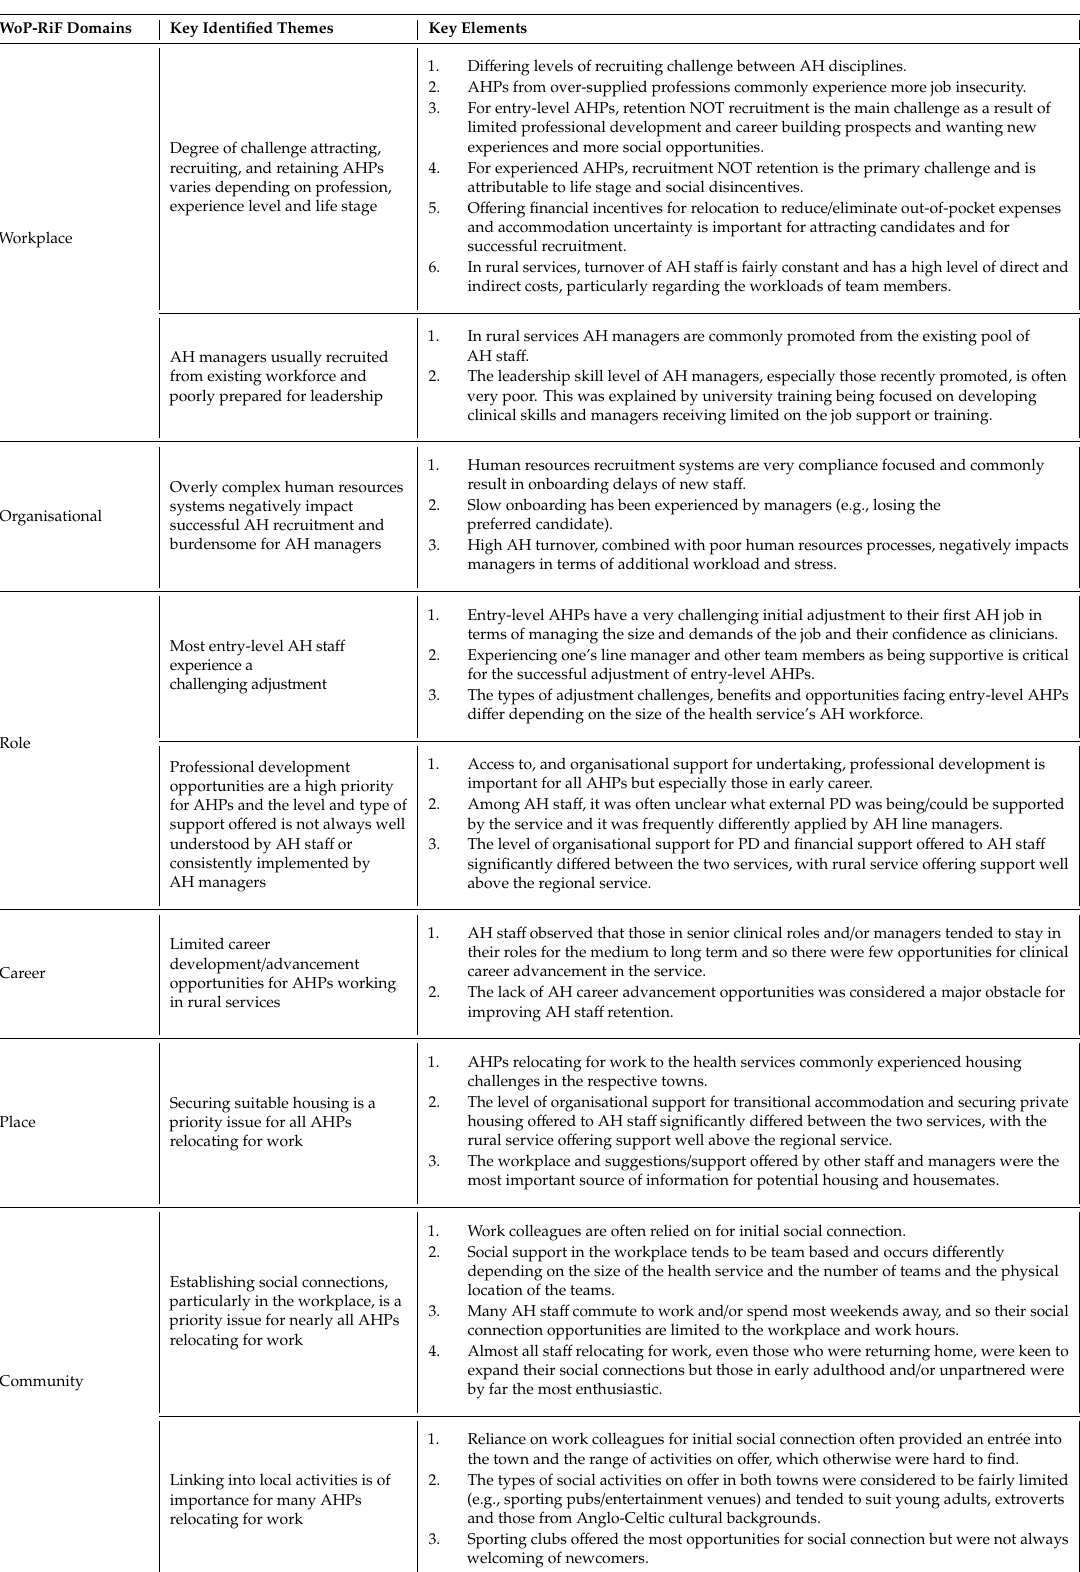
Table3. Thekeyidentifiedthemesandelementsperceivedandexperiencedasimpactingtherecruitment and retention of allied health professionals